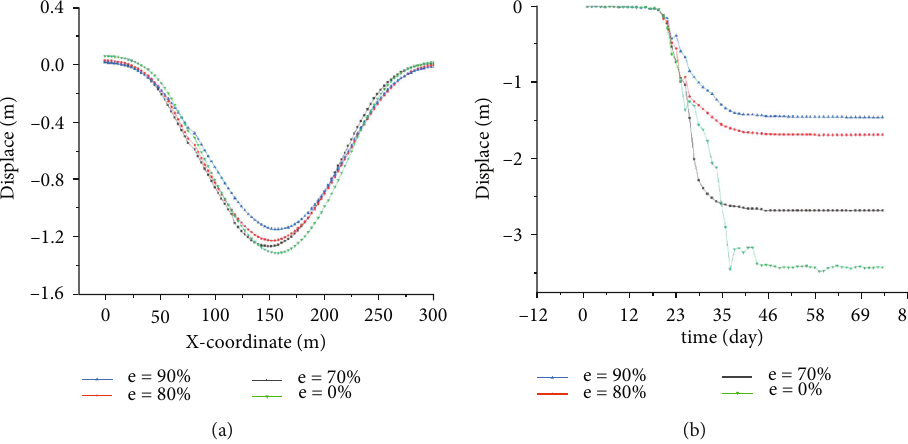
Figure 10: Subsidence curves: (a) ground subsidence curve; (b) roof subsidence curve.